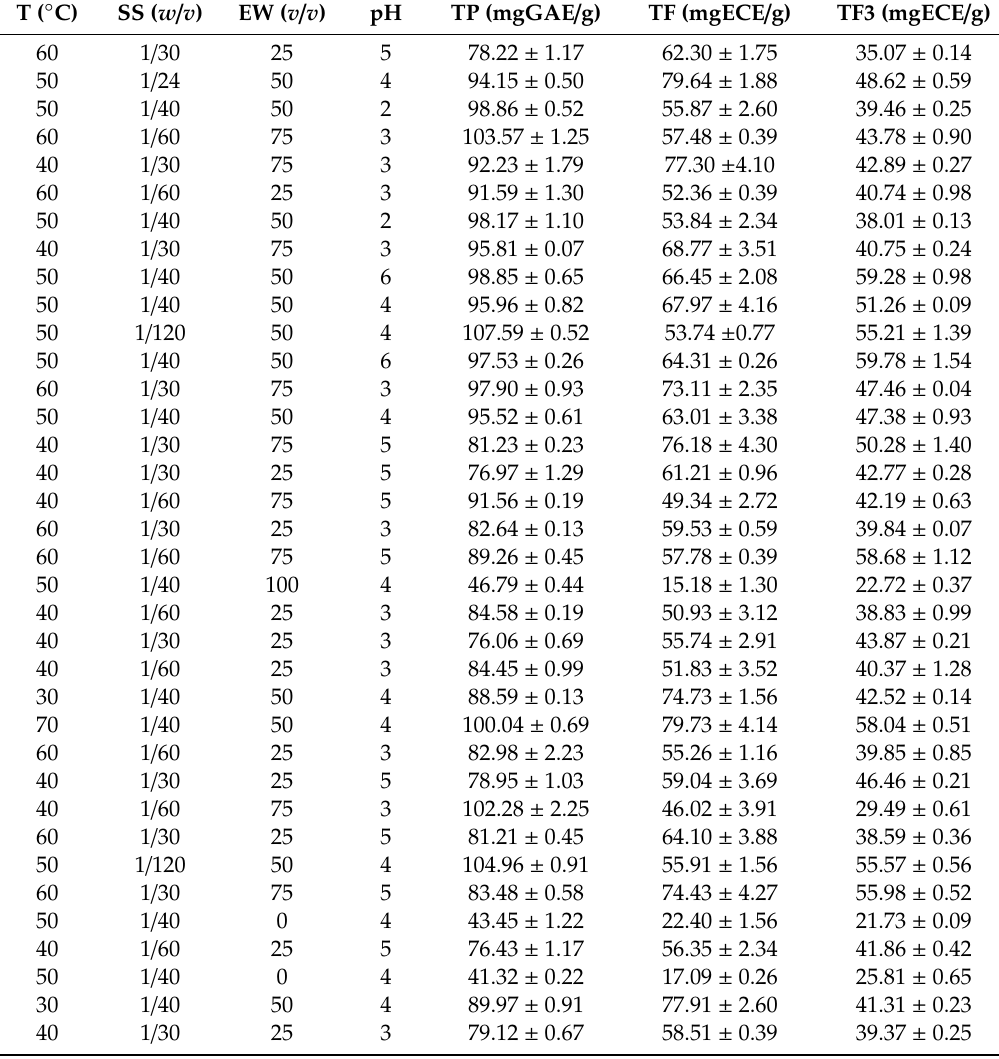
Table 2. 2 4 full factorial central composite rotatable design and experimental results for total polyphenol, total flavonoids, and total flavan-3-ols recovery from cocoa